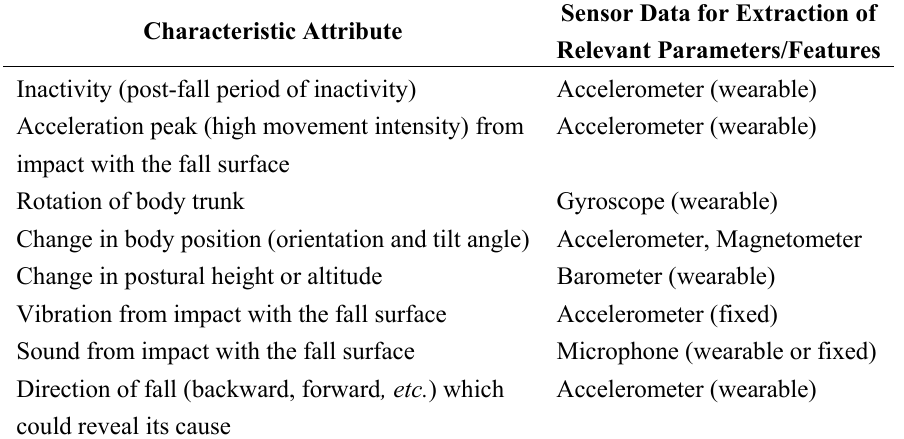
Table 8. Fall characteristic attributes and sensor data